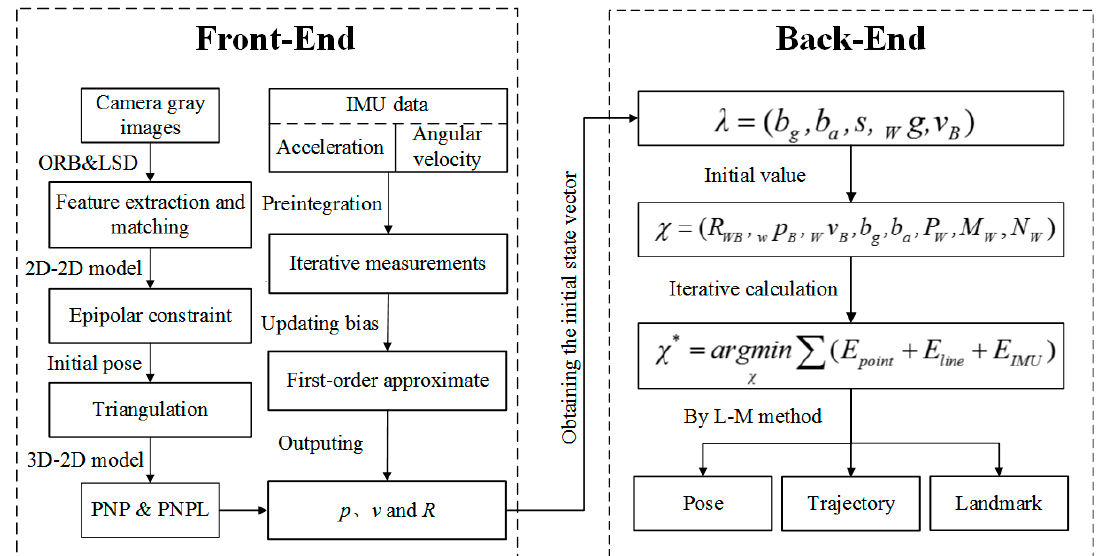
Figure 1. Flow chart of a VIO state estimator algorithm.